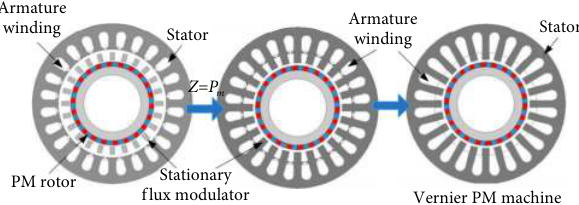
Fig. 16 Topology transferring from basic model to vernier machine (re- printed with permission from Ref. [57], © 2015